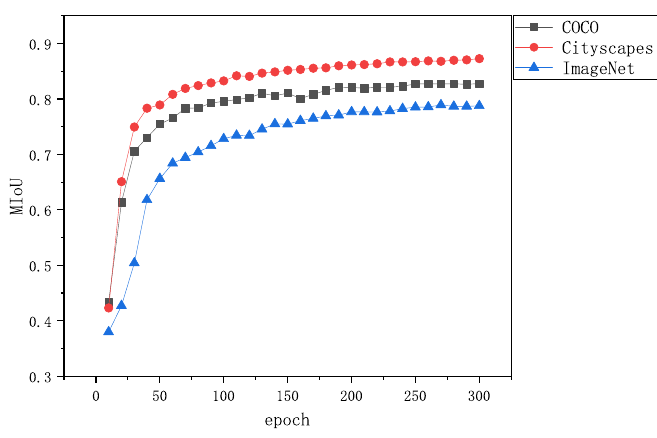
Figure 9. Mean intersection over Union (MIoU) result on the validation set over the model pre-trained by ImageNet, COCO, or Cityscapes dataset.